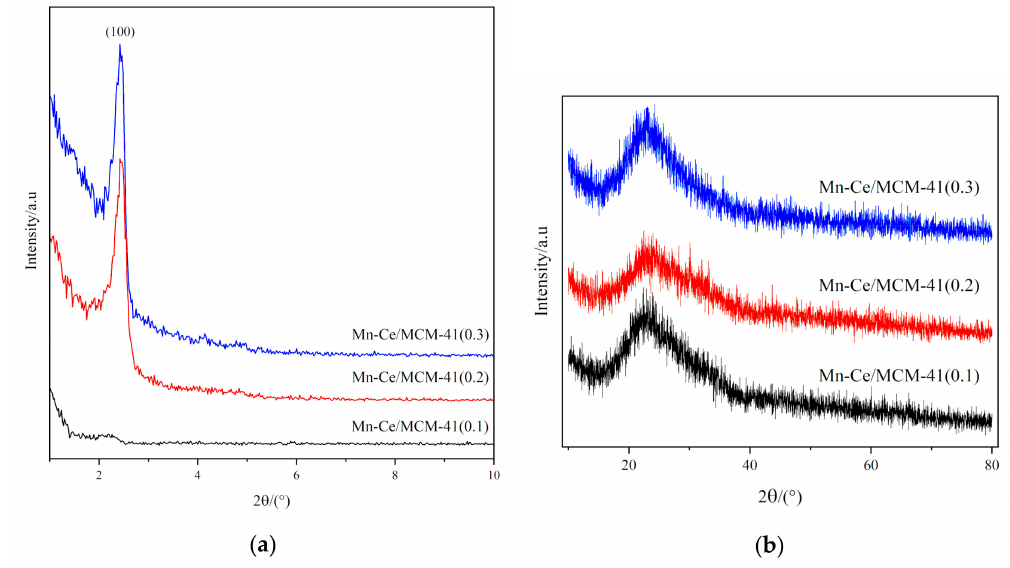
Figure 10. XRD patterns of Mn-Ce / MCM-41(x): ( a ) 2 θ = 1–10 ◦ ; ( b ) 2 θ = 10–80 ◦